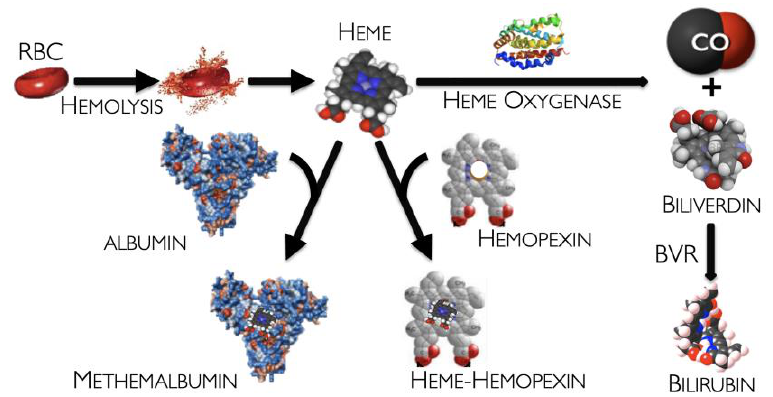
Figure 2. Heme catabolism and binding. RBCs, red blood cells; CO, carbon monoxide; BVR, biliverdin reductase.